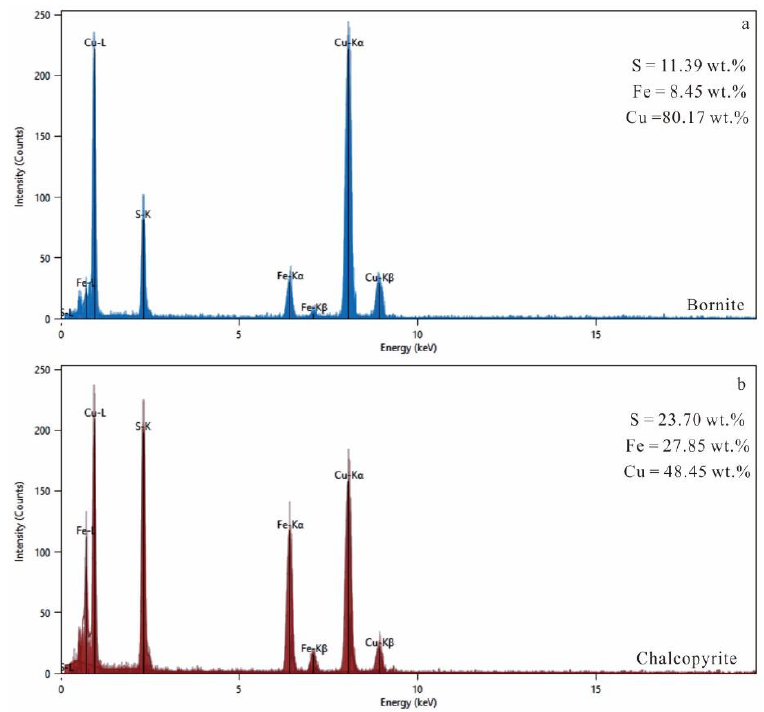
Figure 2. ( a ) TEM-EDS spectra for bornite; ( b ) TEM-EDS spectra for chalcopyrite.